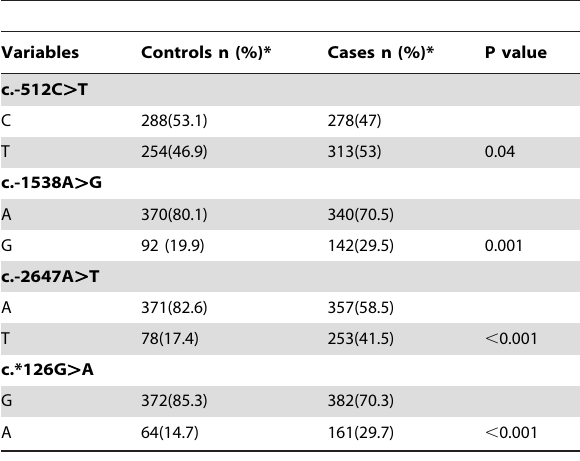
Table 5. Association of allelic frequencies of FoxC2 polymorphisms in patients with CVD and control subjects.